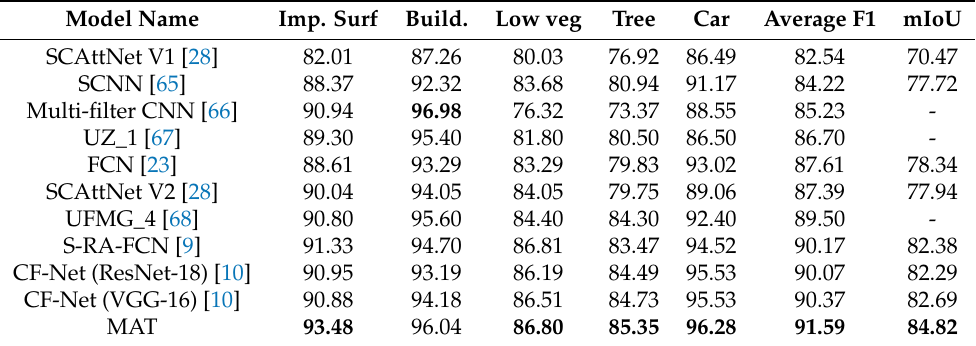
Table 1. Comparison with state-of-the-art methods on the Potsdam dataset. Bold type indicates the best performance.